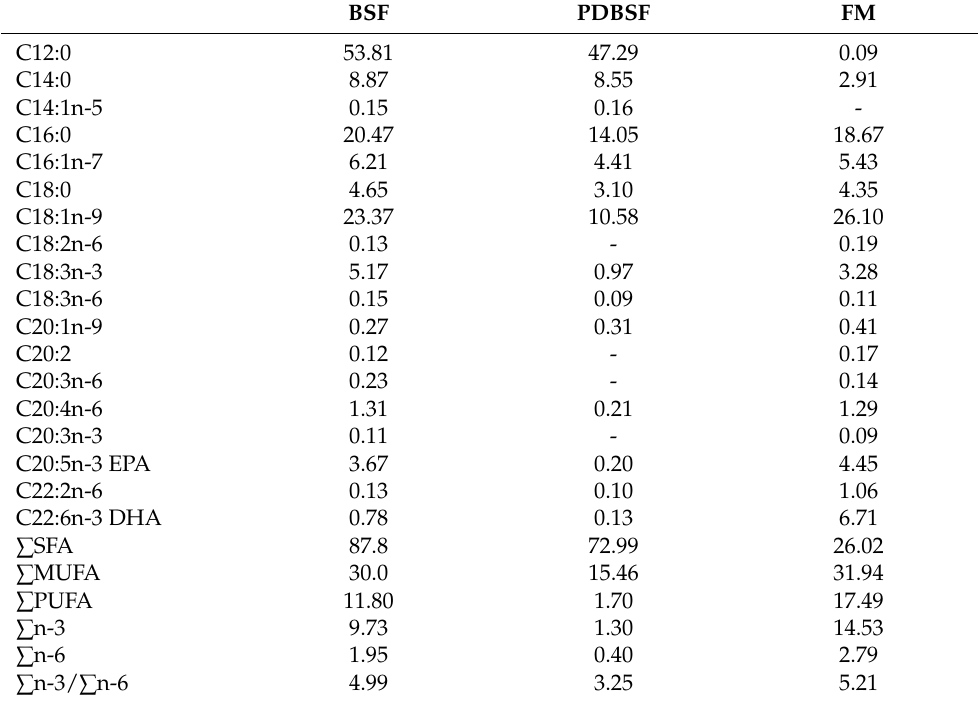
Table 2. Fatty acid composition (g/100 g of sample on DM-basis) of black soldier fry (BSF), partially defatted black soldier fry (PDBSF), and fishmeal (FM) used in the study.